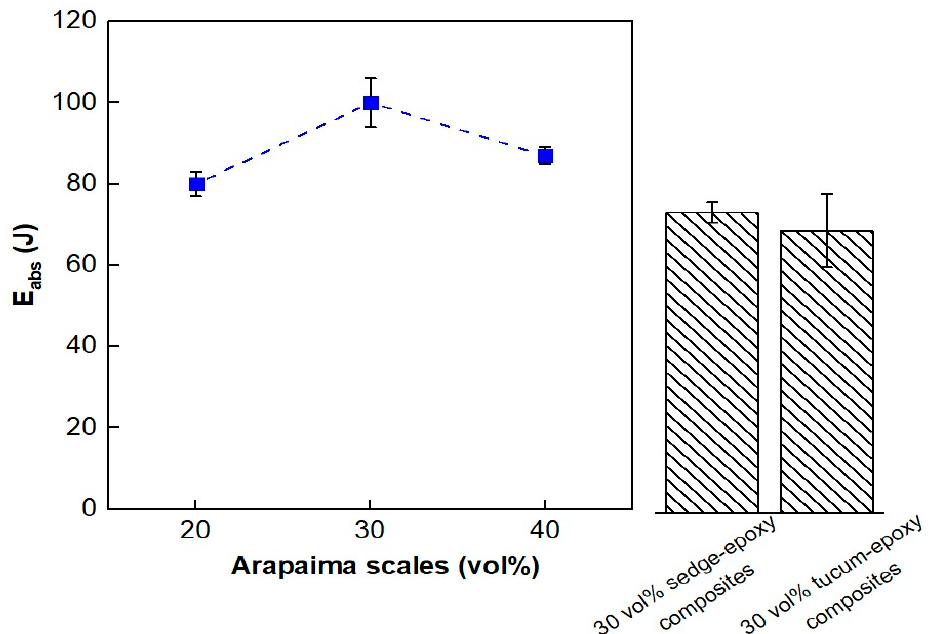
Figure 4. Average absorbed energy values of the composites reinforced with 20, 30, and 40 vol% of arapaima scales against 0.22 ammunition compared to those reported for sedge [40] and tucum [41] fiber-reinforced composites.